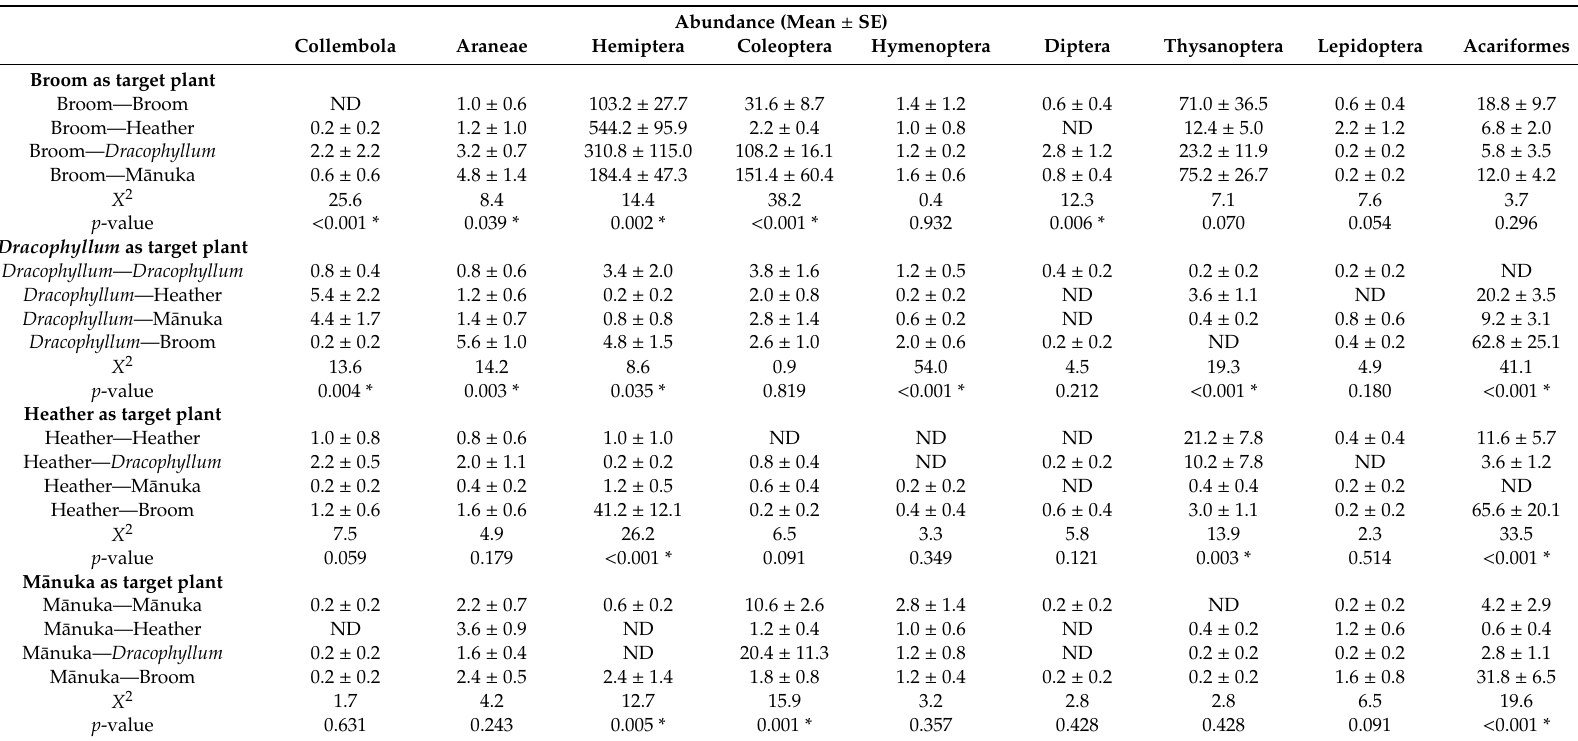
Table 4. Arthropods on target plants when paired with either conspecific or heterospecific neighbours in summer. Arthropods were caught by beating a similar proportion of foliage of each target plant onto a tray ( n = 5). Comparisons between sites were performed using a negative binomial generalised linear model. Site was used as the predictor, while arthropod groups were the response variables. The likelihood ratio test was used to assess the significance of the